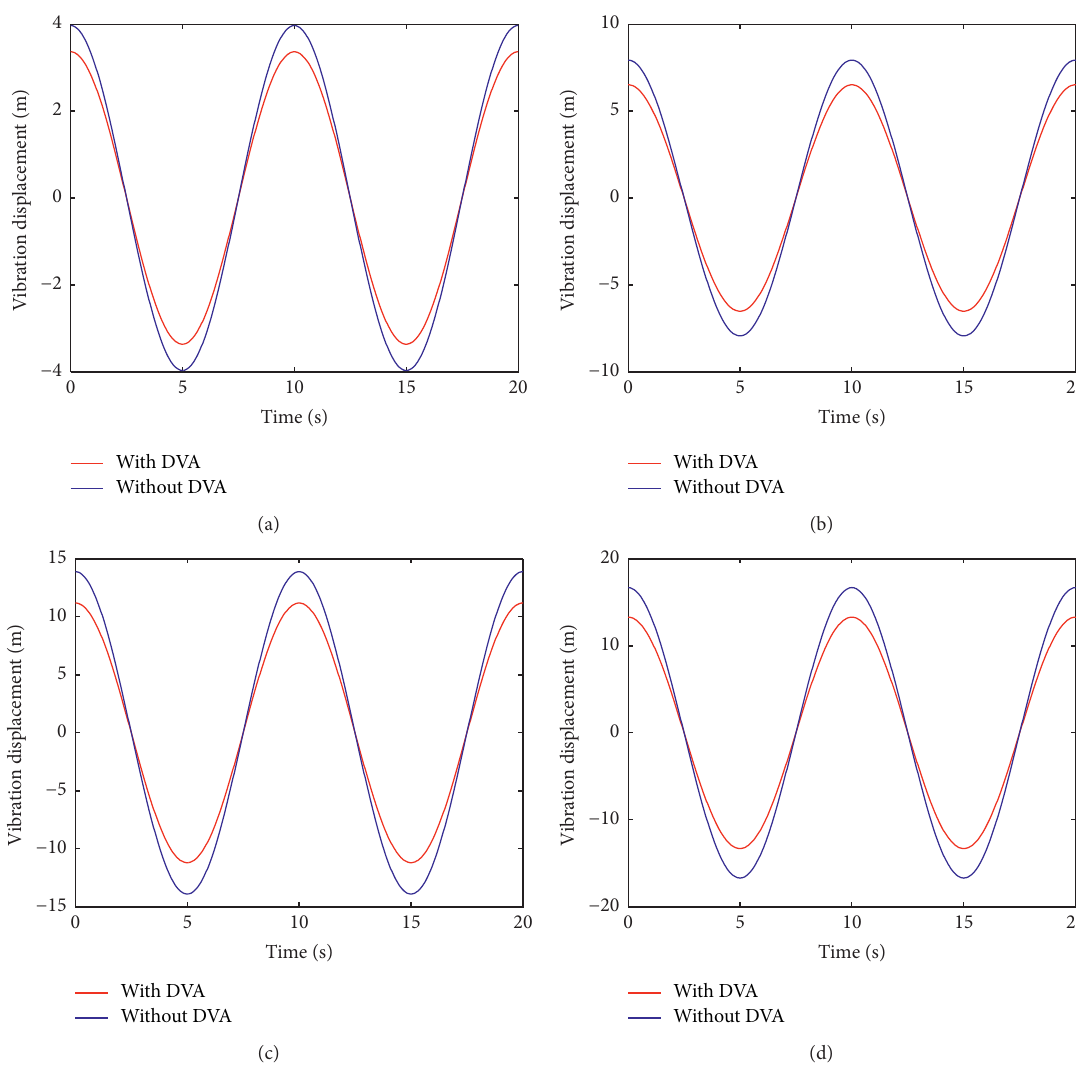
Figure 12: Longitudinal displacements of the lifting pipe. (a) x � 1000m. (b) x � 2000m. (c) x � 3500m. (d) x �